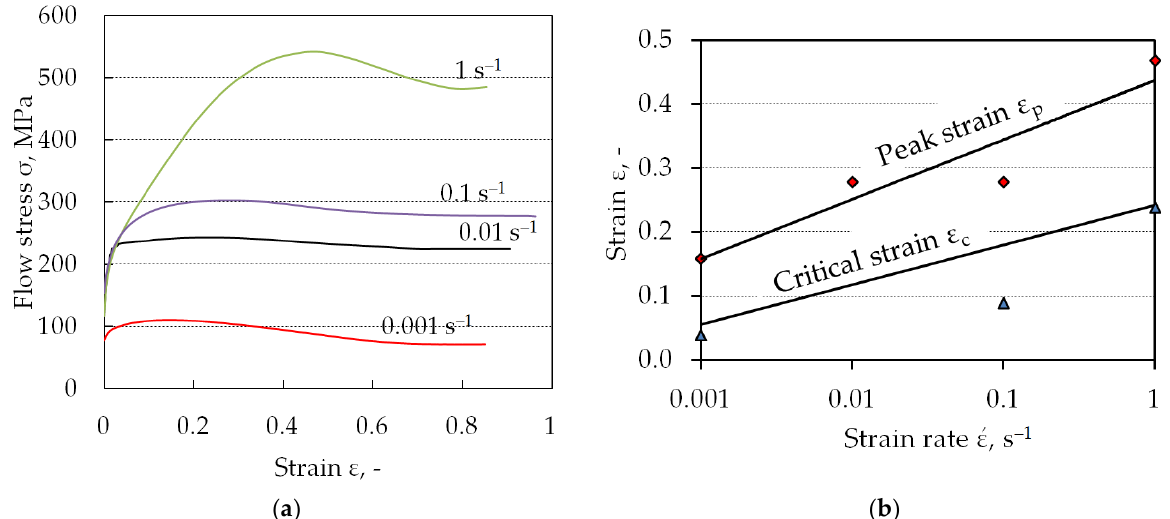
Figure 3. Flow curves ( a ) and influence of strain rate on value of peak strain and critical strain below which was the beginning of dynamic recrystalization (DRX) ( b ). The microstructure after deformation with strain rates 0.001, 0.01, 0.1, and 1 s −1 is presented in Figure 4.